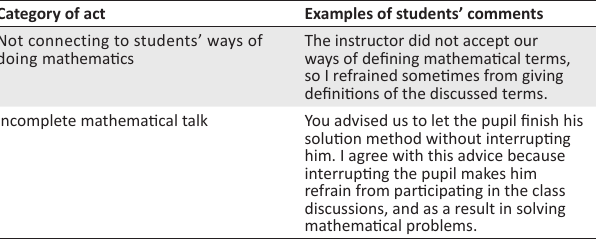
TABLE 12 : Didactic acts discouraging dialogue. Category of act Examples of students’